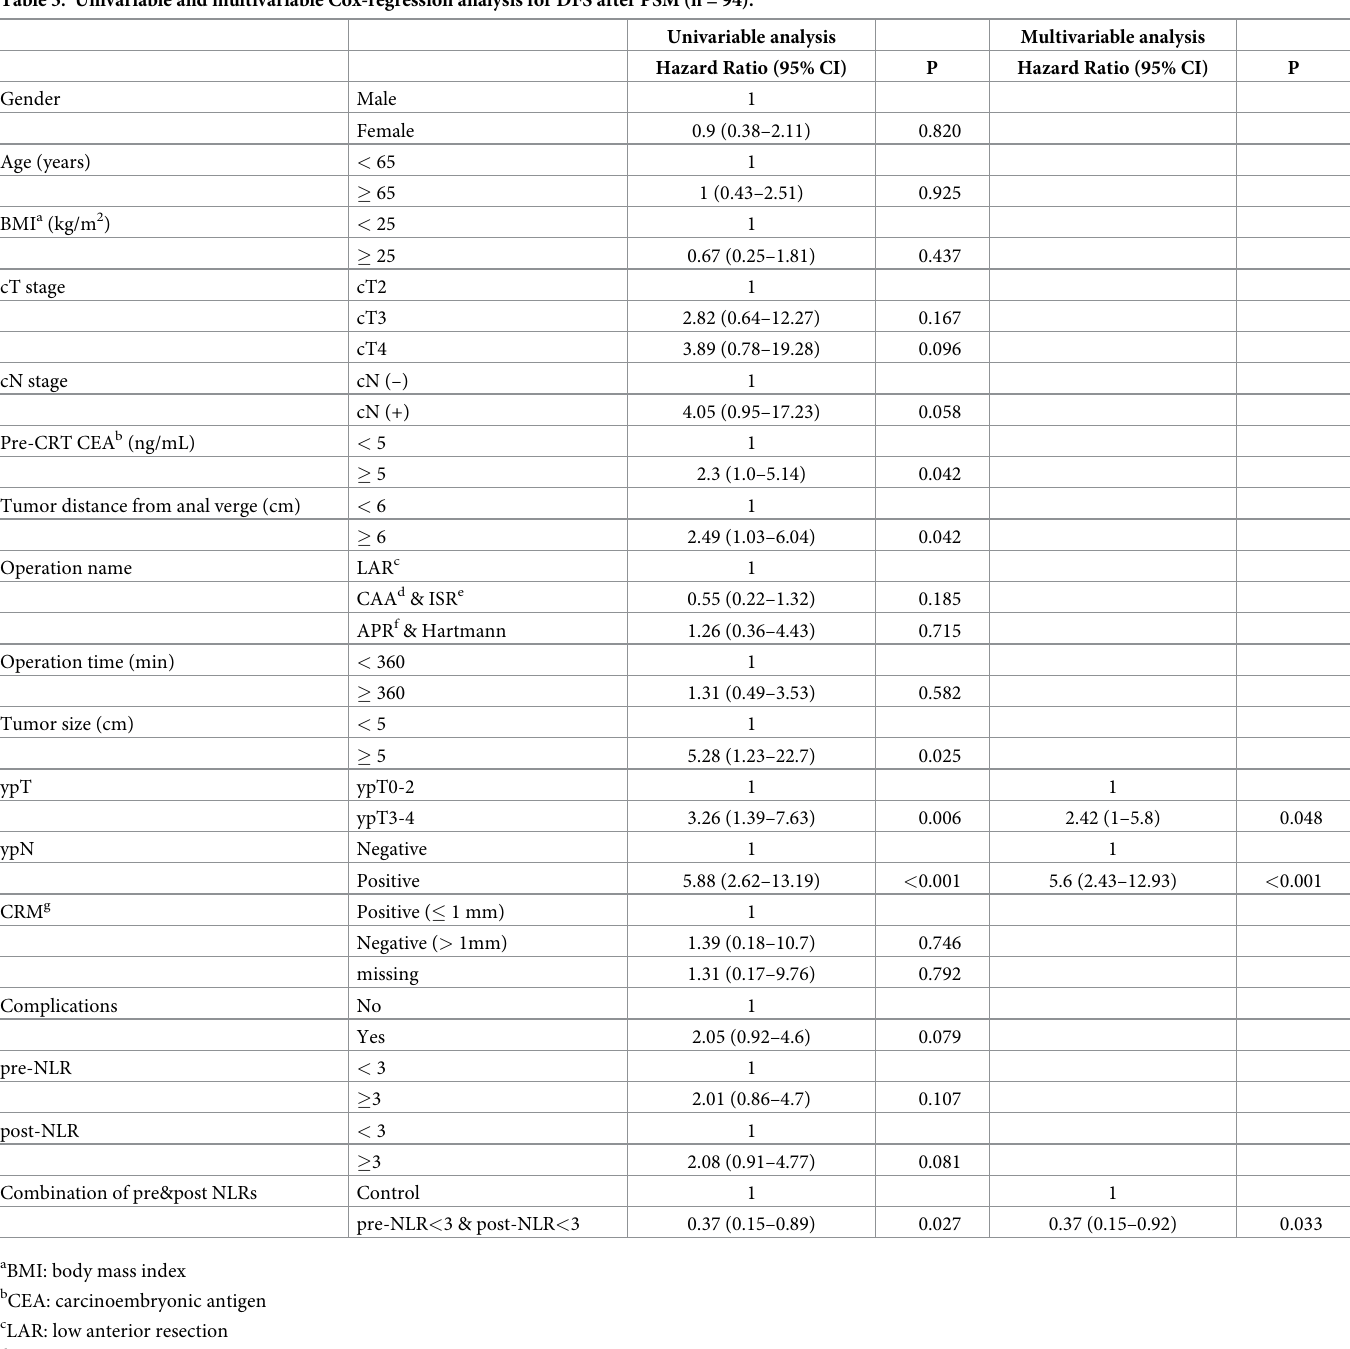
Table 3. Univariable and multivariable Cox-regression analysis for DFS after PSM (n =